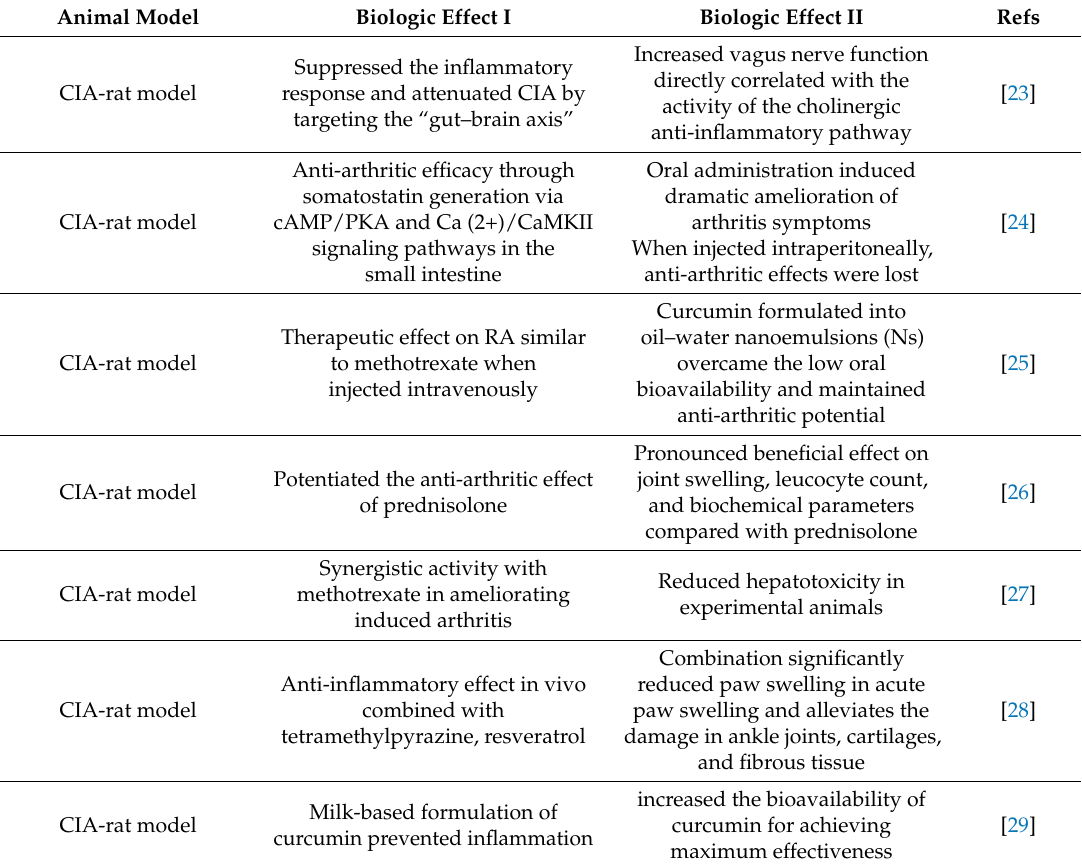
Table 1. Curcumin’s biological effects in animal models of experimental